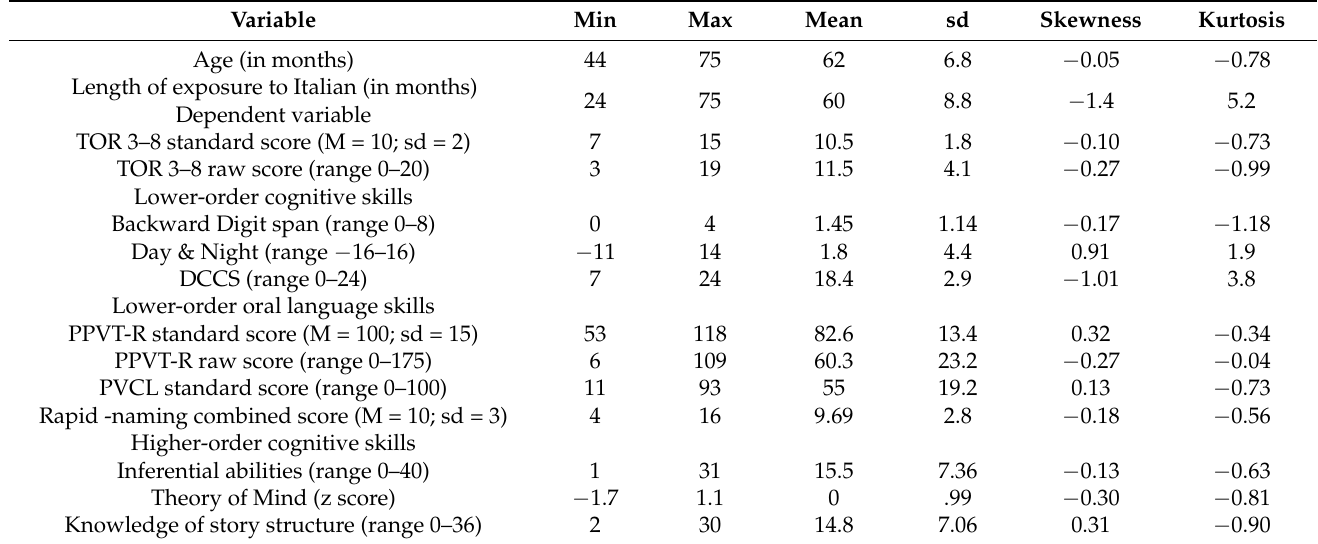
Table 1. Descriptive statistics and Characteristics of the